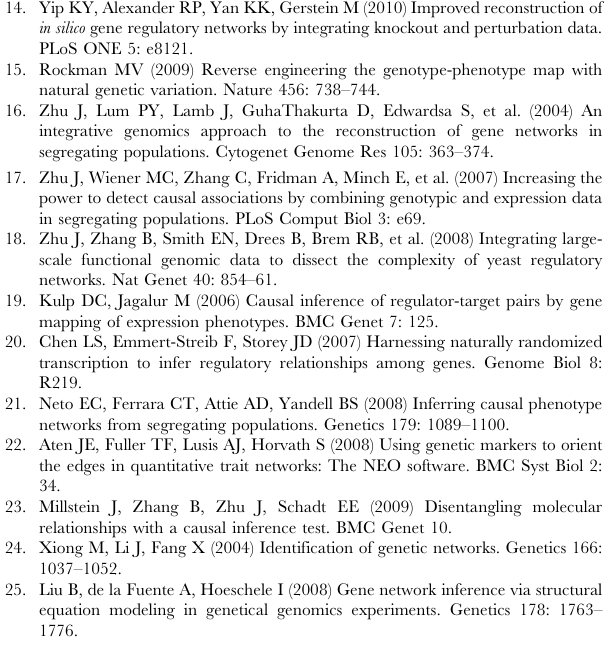
Figure S1 Performance of the SML algorithm for DAGs [(a) and (b)] or DCGs [(c) and (d)] of N g = 30 genes obtained with 5 (solid line) or 10 (dashed line) fold cross validation. Expected number of nodes per node is N e ~ 3 . PD and FDR were obtained from 100 replicates of the network with different sample sizes from 100 to 1,000. Figure S2 Performance of the SML algorithm for DAGs [ (a) and (b)] or DCGs [(c) and (d)] of N g = 30 genes obtained with the optimal l (solid line) or an l 10% less than the optimal l (dashed line). Expected number of nodes per node is N e ~ 3 . PD and FDR were obtained from 100 replicates of the network with different sample sizes from 100 to 1,000. Figure S3 Performance of the SML algorithm with stability selection (STS) or cross validation for DAGs [ (a) and (b)] or DCGs [(c) and (d)] of N g ~ 30 genes. Expected number of nodes per node is N e ~ 3 . PD and FDR were obtained from 100 replicates of the network with different sample sizes from 100 to 1,000.